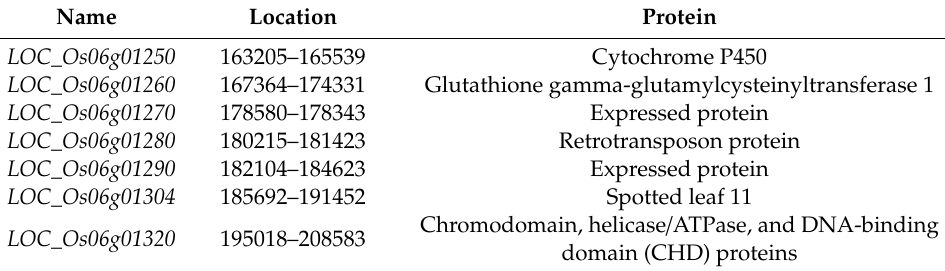
Table 4. Candidate genes in the 45.8 kb target region corresponding to qLTG6.